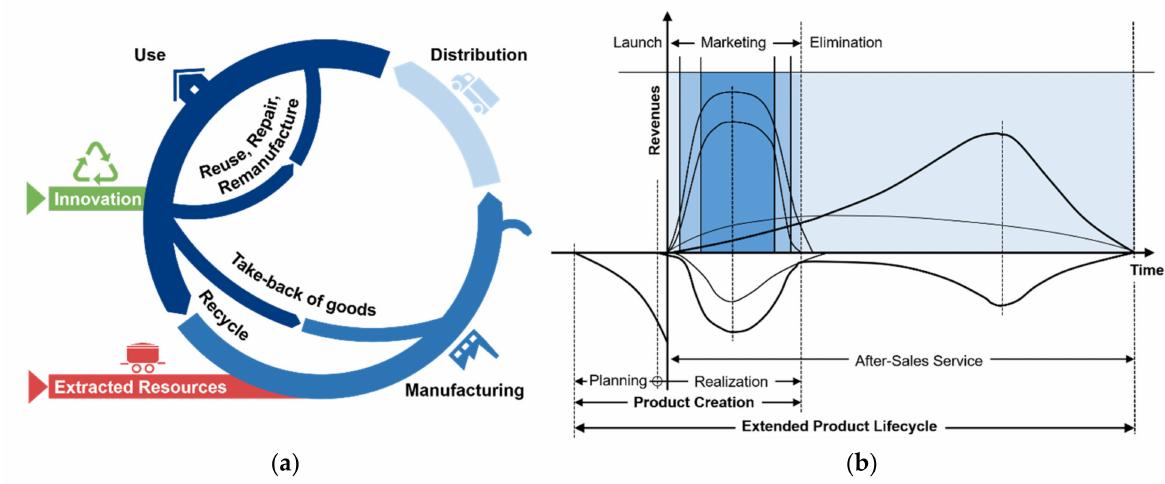
Figure 4. Cross-cutting perspectives of the product lifecycle: ( a ) material flow in Circular Economy with innovation opportunities along all lifetime phases (based on [58]); ( b ) economic perspective of product–service systems, highlighting temporal effects of Product Creation (time of series production) and continuation of service in after-sales (based on